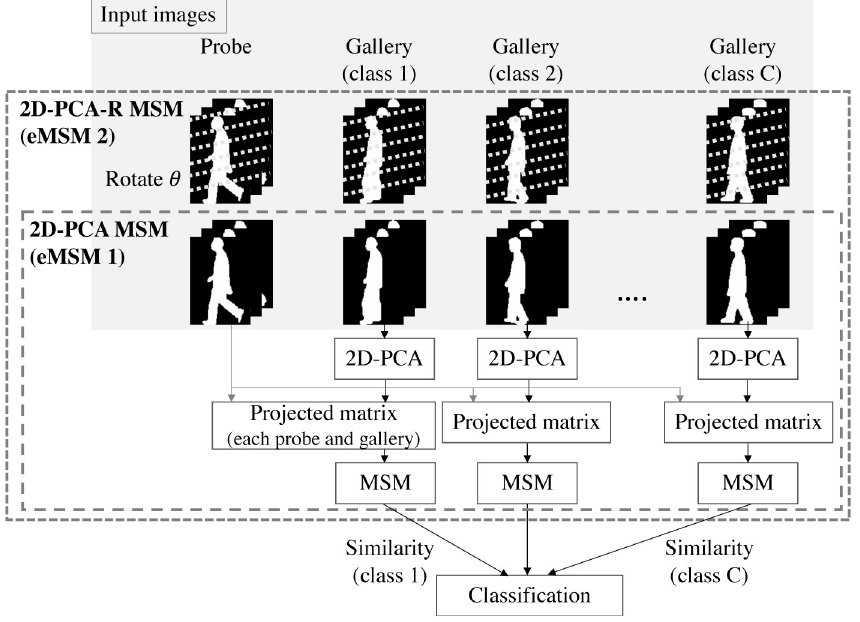
Fig 5. Overview of 2D-PCA MSM (smaller dotted rectangle) and 2D-PCA-R MSM (larger dotted rectangle).